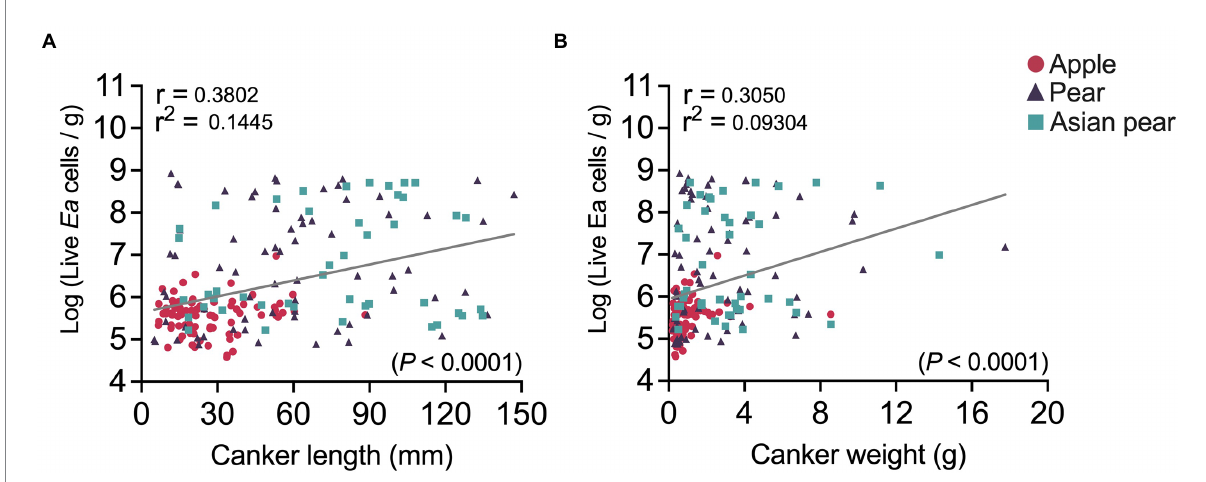
FIGURE 6 Correlation between fire blight canker sizes (length, chart A ; weight, chart B) and E. amylovora live cell concentrations in cankers. Each chart shows the Pearson coefficient of correlation ( r ), coefficient of determination ( r 2 ), regression line and p value for the statistical testing. Circles, triangles, and squares indicate E. amylovora population sizes in individual cankers from apple (‘Cortland’, ‘Cameo’ and ‘Honeycrisp’), pear (‘Bosc’ and ‘Bartlett’), and Asian pear (‘Hosui’, ‘Shinko’, and ‘Yoinashi’), respectively. All the analyzed samples are from non-irrigated trees in the first experiment repeat. The negative cankers for E. amylovora detection were excluded from the